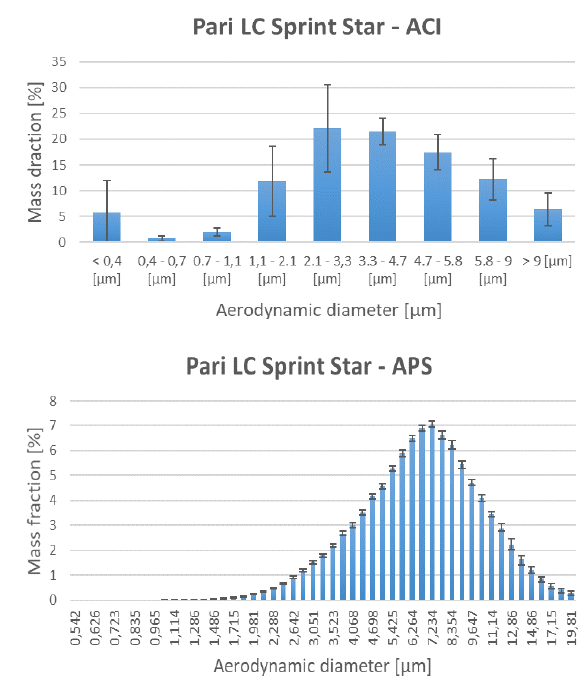
Fig . 2 . Upper distribution - APSD of aerosol generated by PARI LC Sprint measured by APS; Lower distribution - APSD of aerosol generated by Pari LC Sprint Star measured by